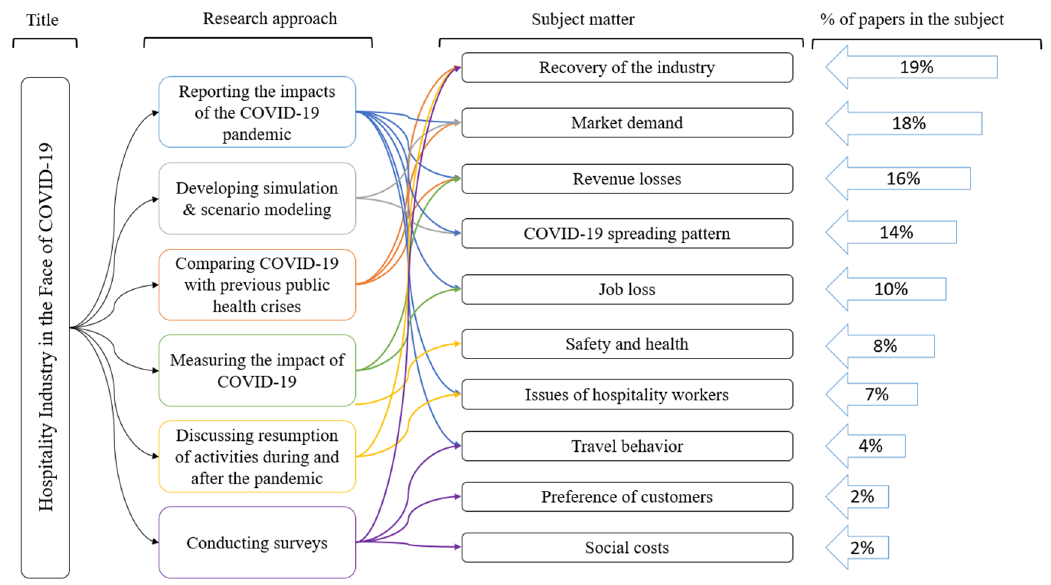
Figure 6. Research aspects of the hospitality industry among included papers.